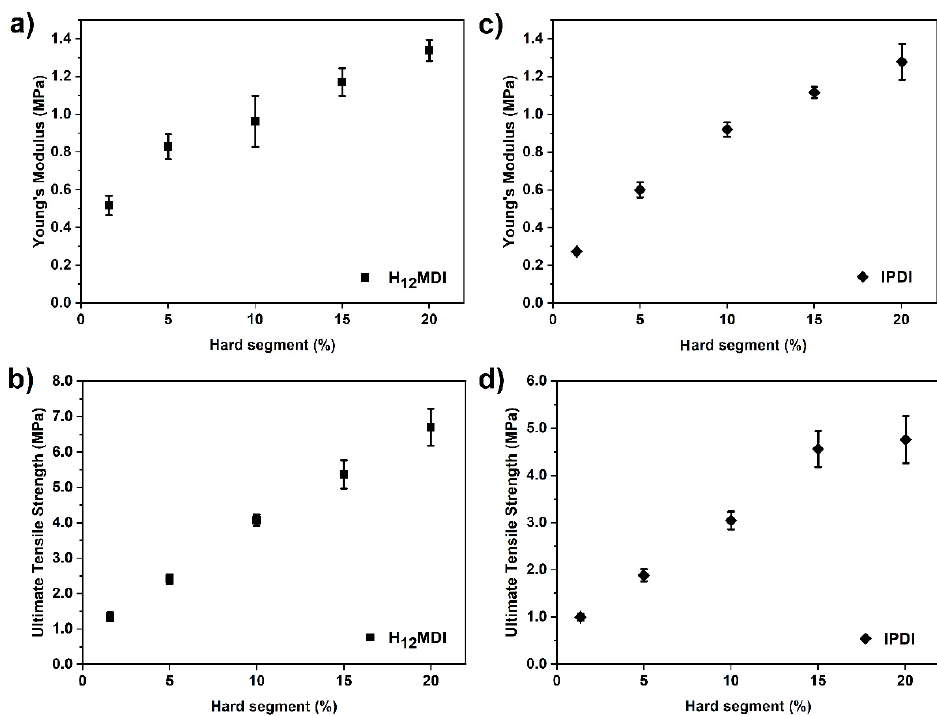
Figure 7. YM and ultimate tensile strength (UTS) values of PSU elastomer films synthesized from ( a , b ) H 12 MDI and ( c , d ) IPDI as a function of HS content. The values at approximately 1.6% and 1.4% HS content correspond to copolymers that were synthesized without chain extenders. The values between 5% and 20% HS content correspond to PSU elastomers that were chain-extended with APTMDS. The YM values of the PSU H 12 MDI-elastomers increases approximately linearly from 0.8 to 1.3 MPa. In the IPDI series, the values for YM increase logarithmically from approximately 0.6 to 1.3 MPa. UTS increases linearly with increasing HS content from 1.3 to 6.7 MPa (H 12 MDI) and from 1.0 to 4.6 MPa (IPDI). The value at 20% HS content in the IPDI series deviates slightly from linearity. The error bars represent the standard deviation from five measurements.